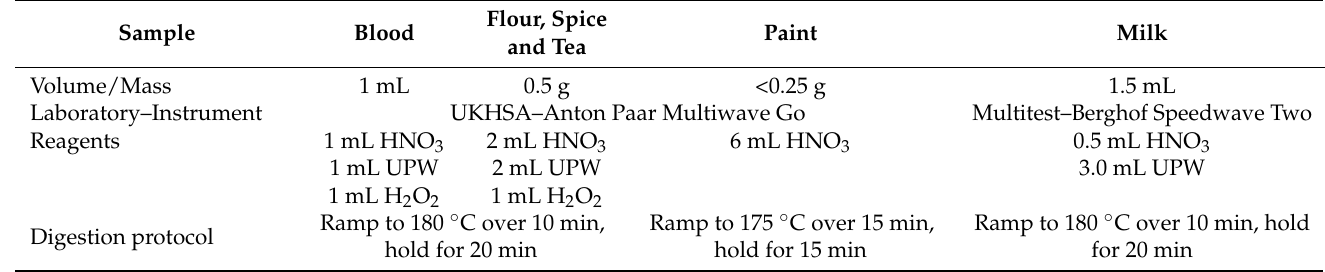
Table 1. Summary of microwave-assisted acid digestion protocols used for sample